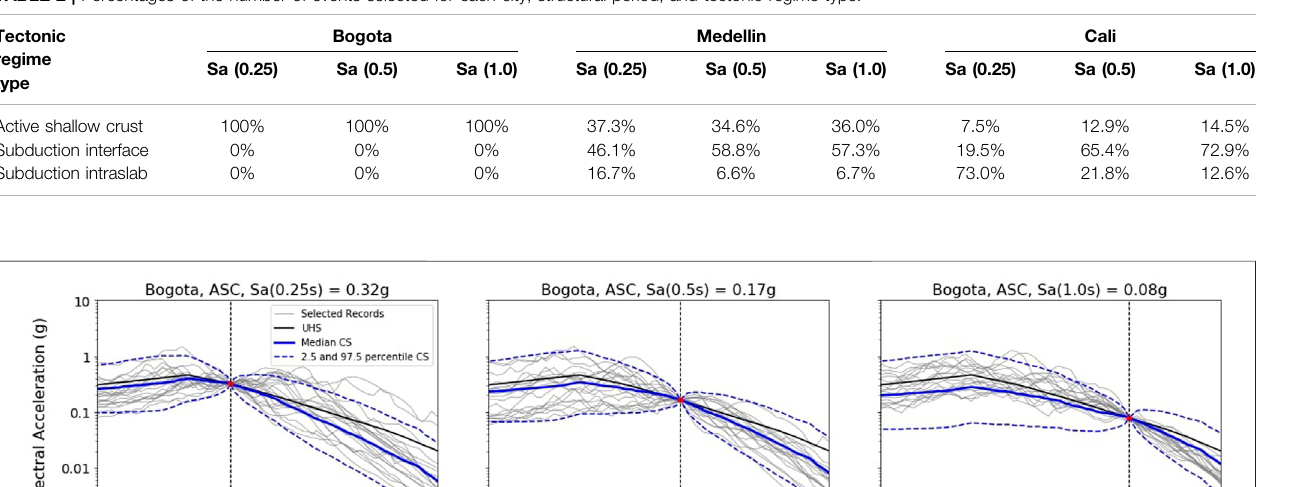
Frontiers in Earth Science |